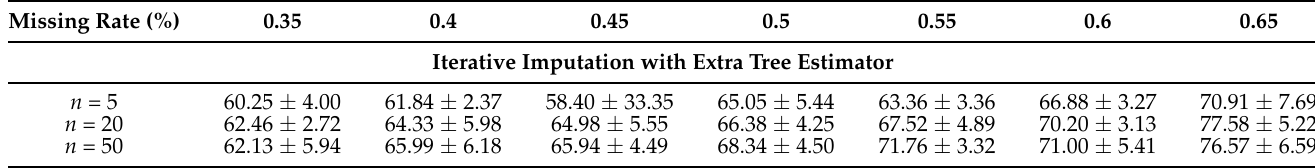
Table 4. The mean and standard deviation of SMAPE in ExtraTree with different tree numbers.